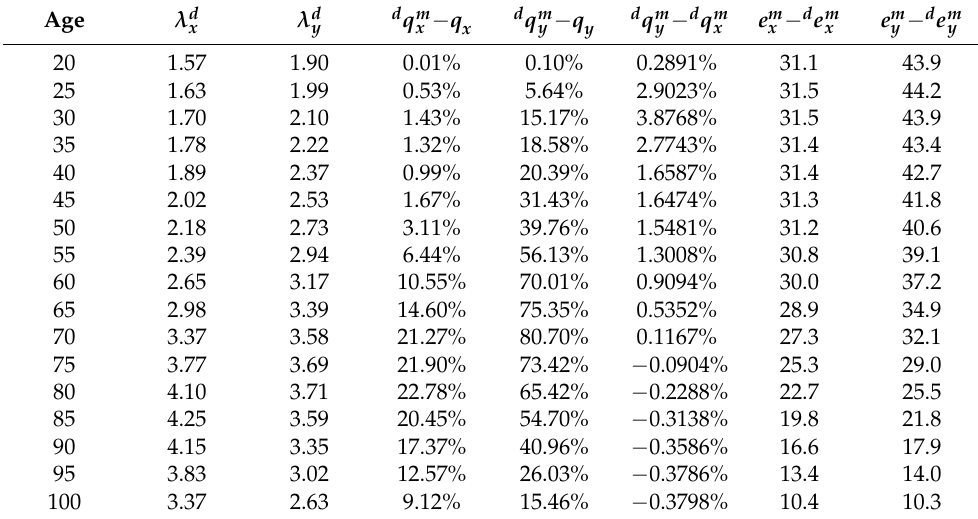
Table 4. Main results for people born in 1970, values by sex and age. Source: Own